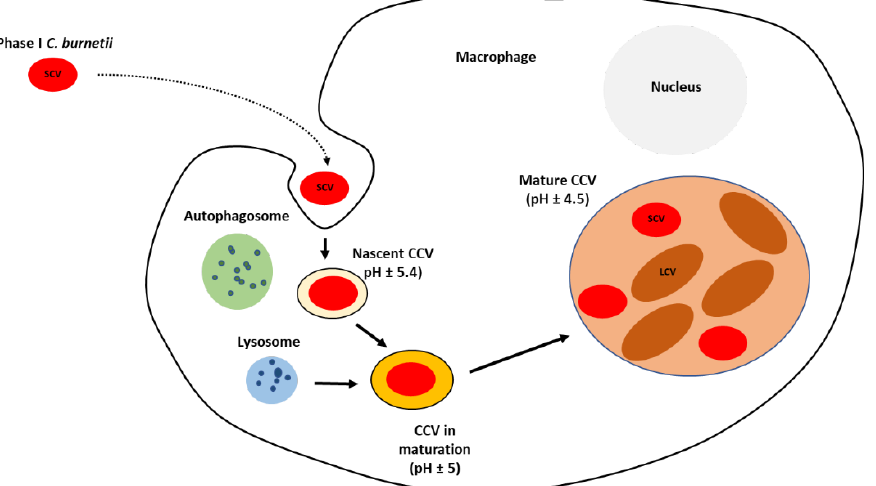
Figure 2. Diagram of the intracellular lifecycle of C. burnetii . CCV— Coxiella -containing vacuole; SCV—small cell variant; LCV—large cell variant.